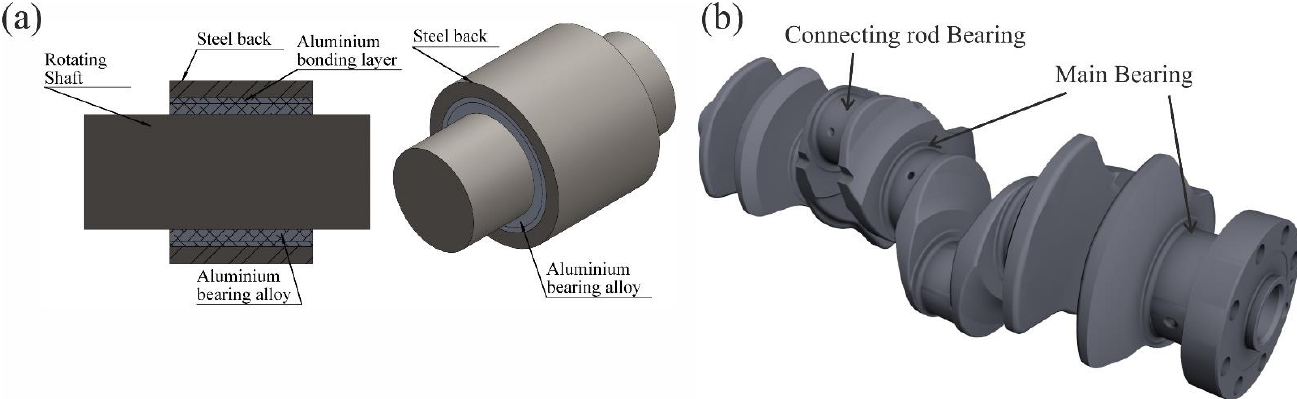
Figure 1. ( a ) Typical construction of metal bearing using Al-based alloys, ( b ) the bearing positions on the crankshaft.